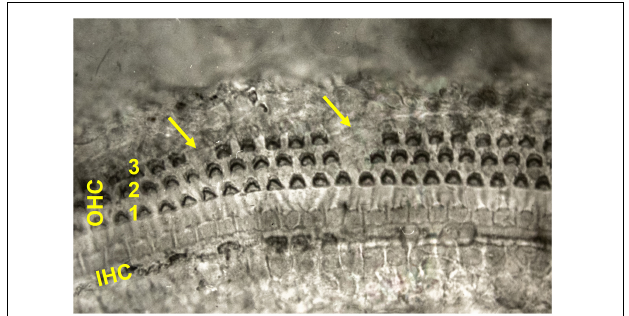
FIGURE 2 | Total surface specimen of the organ of Corti of a shrew ( Sorex araneus ). The geometrical pattern consists of three rows (1–3) of cuticular plates of outer hair cells (OHC) separated by a row of inner pillar cells from a single row of cuticular plates of inner hair cells (IHC, not in focus). Altogether 4 OHC are missing on account of the physiological involution of the auditory neuroepithelium (arrows). Ehrlich’s hematoxylin × 375. See Burda (1978) and Úlehlová et al. (1984) for further illustrations and description of the